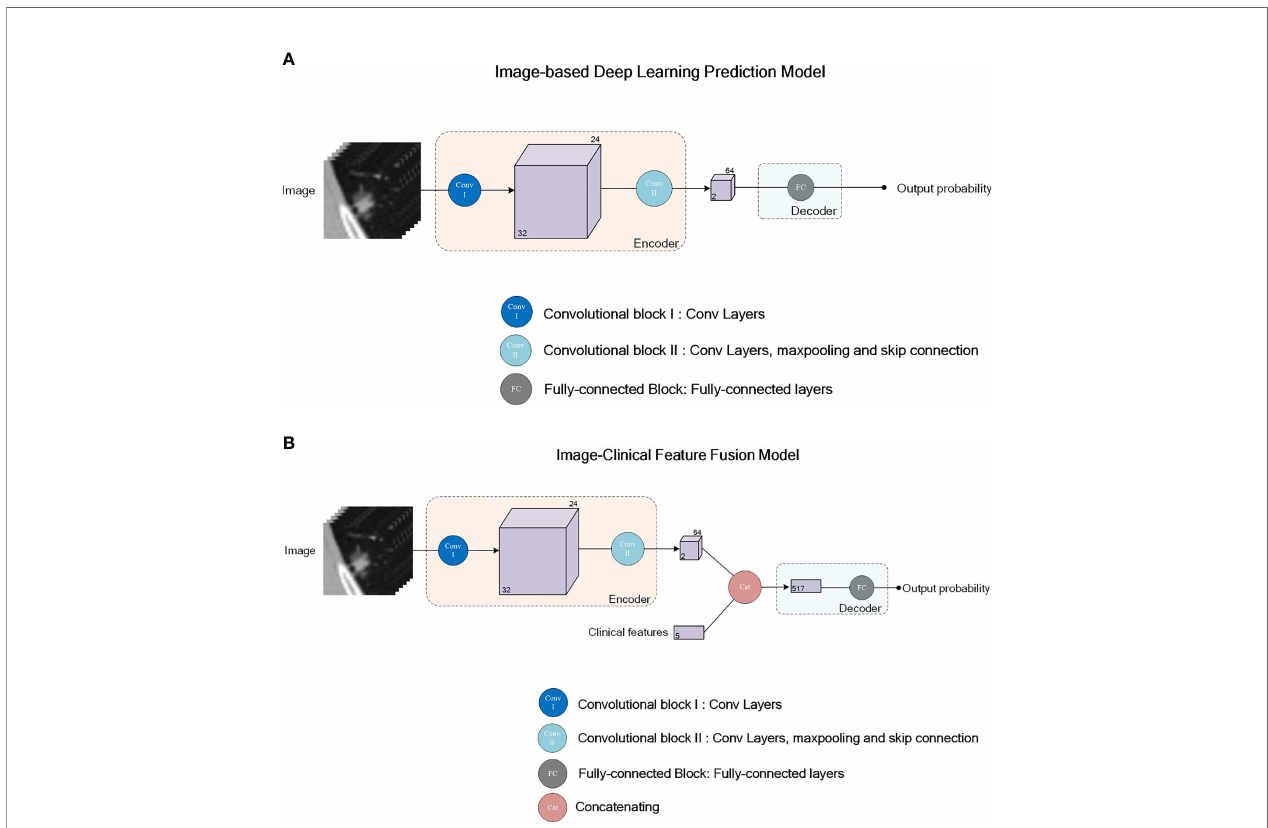
FIGURE 2 | Network structure illustration for the deep learning models IBTL (A) and FPM (B) . Convolutional block I (Conv I) consists of 2 convolutional layers. Convolutional block II (Conv II) consists of 4 Resnet sub-blocks and maxpooling layers after each Resnet sub-block. First two of the Resnet sub-block consists of 4 convolutional layers each, while the last two Resnet sub-blocks consists of 6 convolutional layers each. Skipping connection is adopted in all 4 Resnet-sub blocks. Fully-connected block (FC) consists of 3 fully-connected